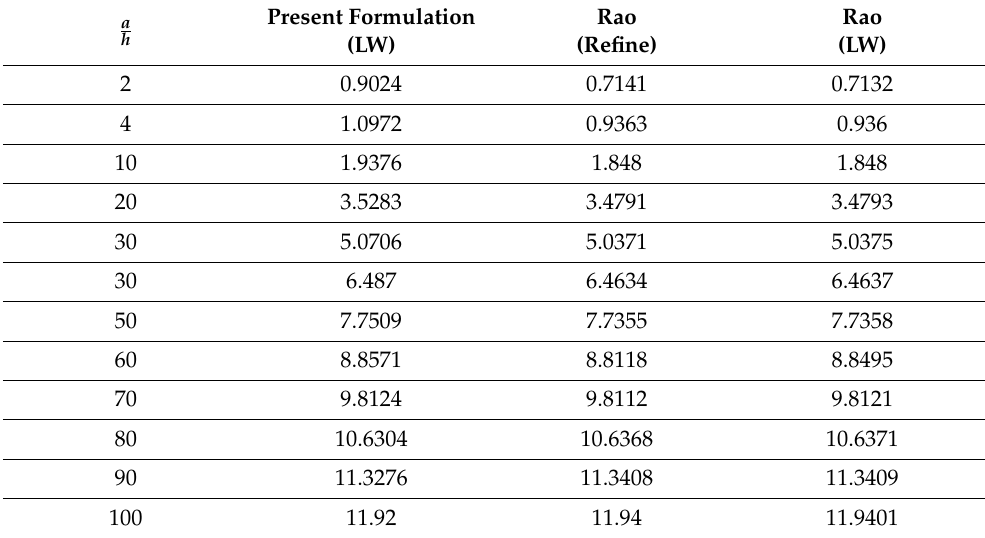
Table 2. Comparison of non-dimensional fundamental frequencies ω of (0 ◦ /90 ◦ /core/0 ◦ /90 ◦ ) = 10 and a = 1. sandwich plate with h 3 h 1 b